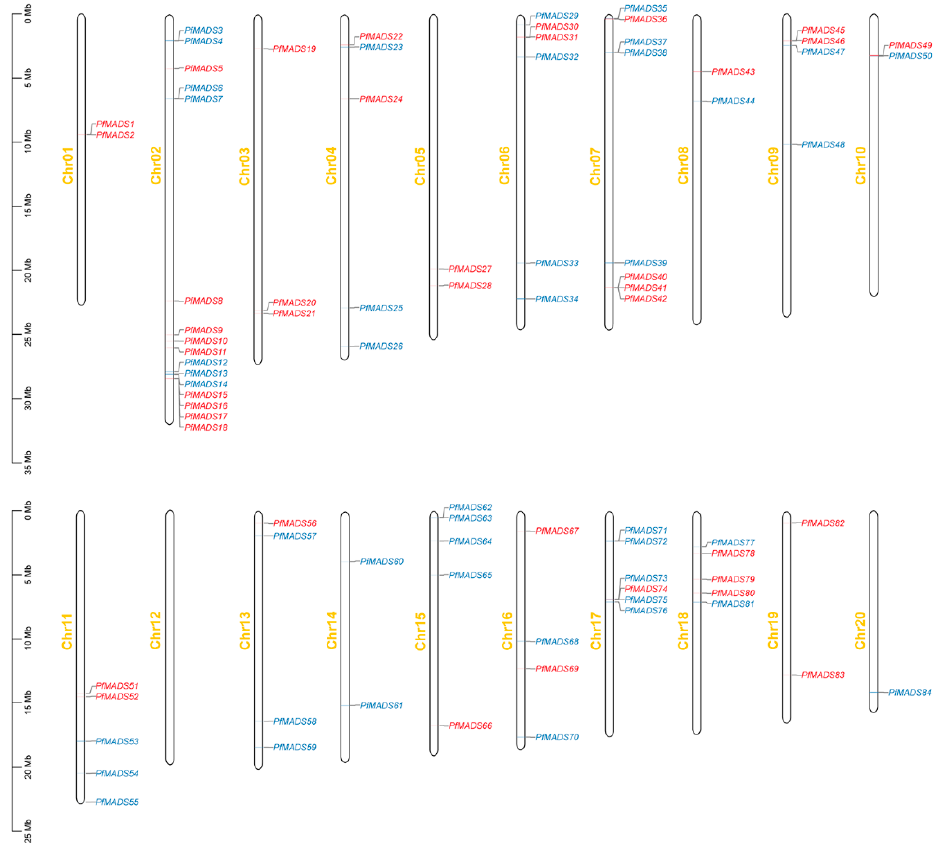
Figure 1. Chromosomal location of PfMADS-box genes in P. fortunei . The scale of the chromosome is millions of base pairs (Mb). Type Ⅰ and type Ⅱ genes are colored red and blue, respectively.